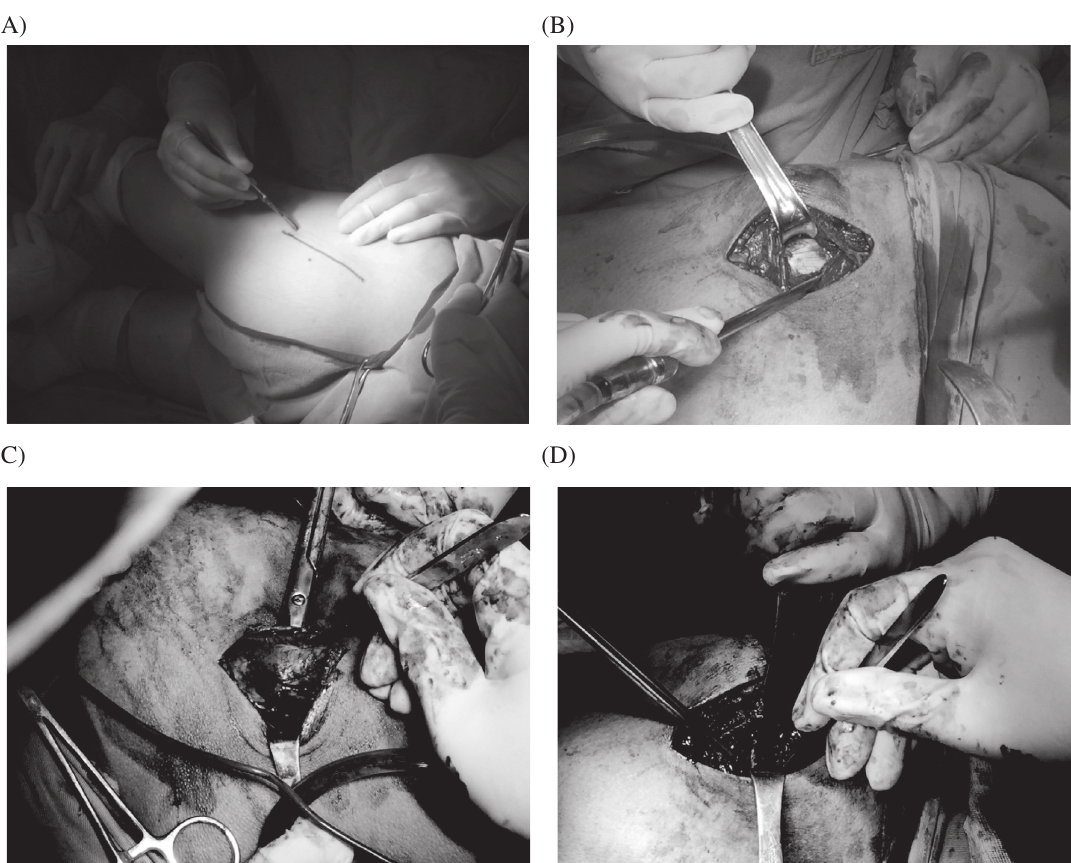
Figure 3. Conventional open gluteal muscle contracture release. (A) The patient was positioned laterally with hip in neutral, a longitudinal skin incision line was drawn over the left buttock; (B) a skin incision was made along the marking line, a fibrotic contracture band appeared as a silvery white structure over the greater trochanter; and (C) and (D) show the division of contracture bands under direct vision, starting from superficial to deeper